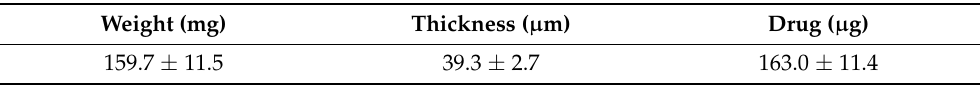
Figure 4. Photo of the apigenin-loaded film. The preparation method was described in detail in the Section 2. Table 2. The mean weight, thickness, and estimated drug content of the three-dimensionally printed film. The drug content in the film was calculated from the weight and film composition. The data are shown as the mean ± SD ( n =